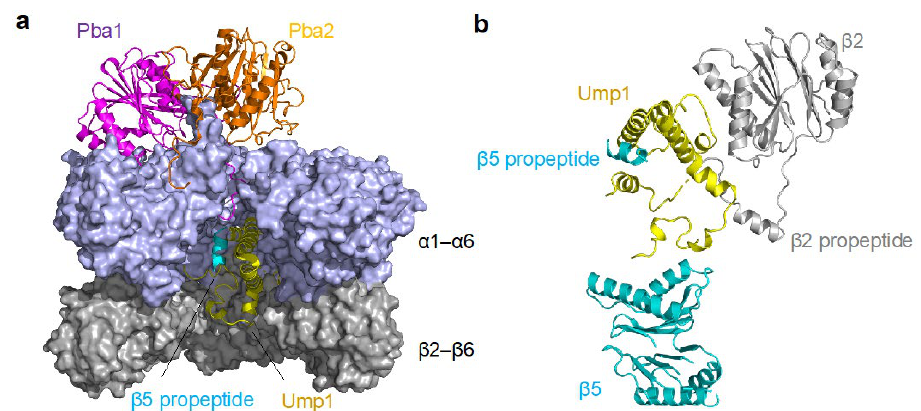
Figure 3. Structure of the pre-15S intermediate complex. ( a ) Cryo-EM structure of the pre-15S CP intermediate complex. The N-terminus of Pba1 extends to the CP interior and interacts with Ump1 and the propeptide of β 5. α 7 is omitted from the original structure (PDB 7LS6) for clarity. ( b ) Interaction between β 2, β 5, and Ump1. Ump1 makes contacts with both the propeptides and main bodies of β 2 and β 5. PyMOL was used for visualization (https://pymol.org/2/support.html), accessed on 27 April